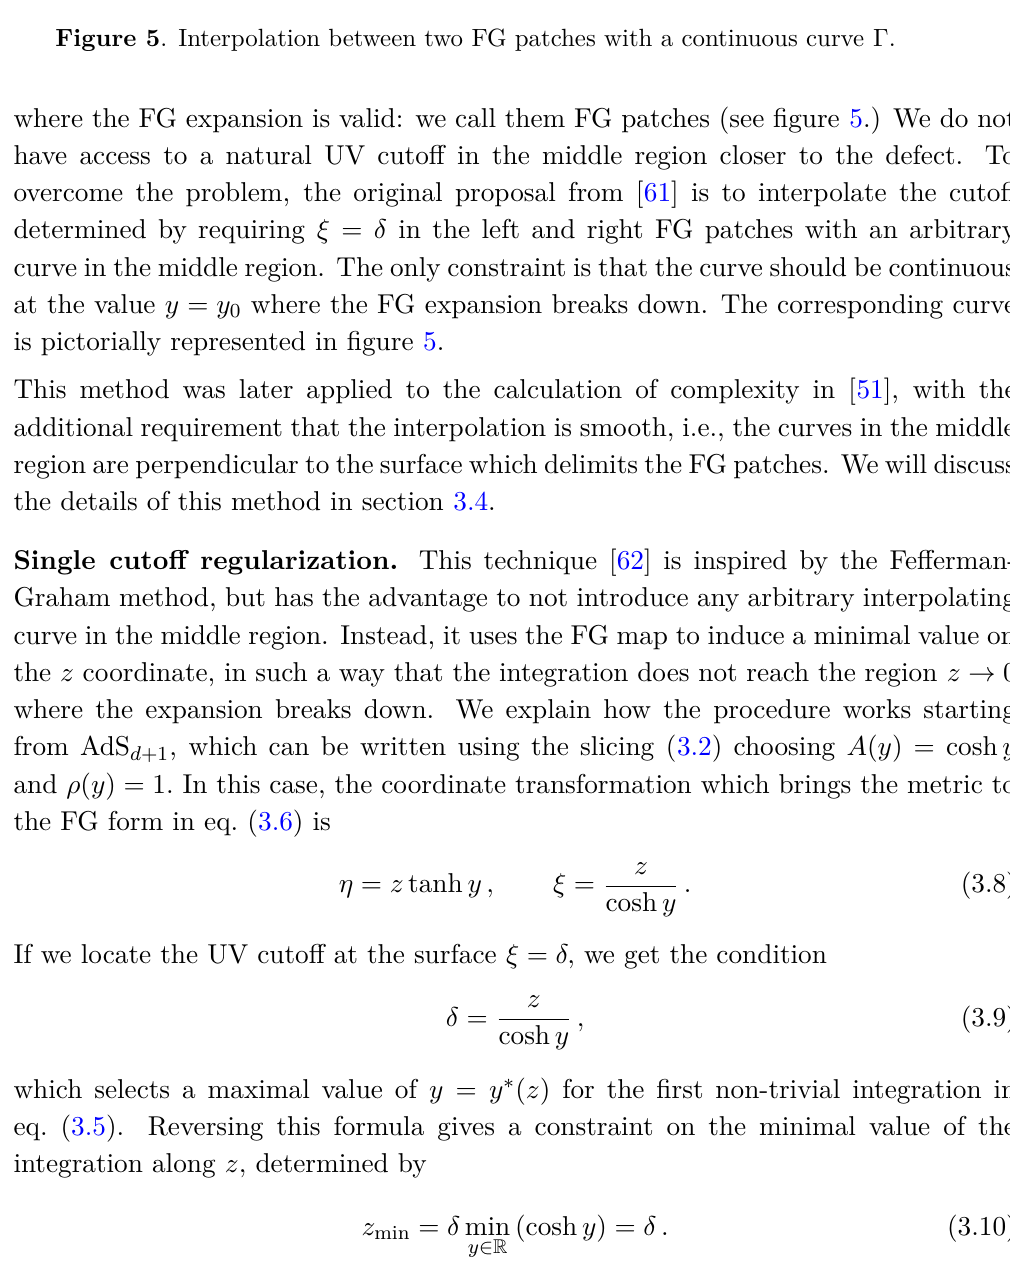
Figure 5 . Interpolation between two FG patches with a continuous curve Γ